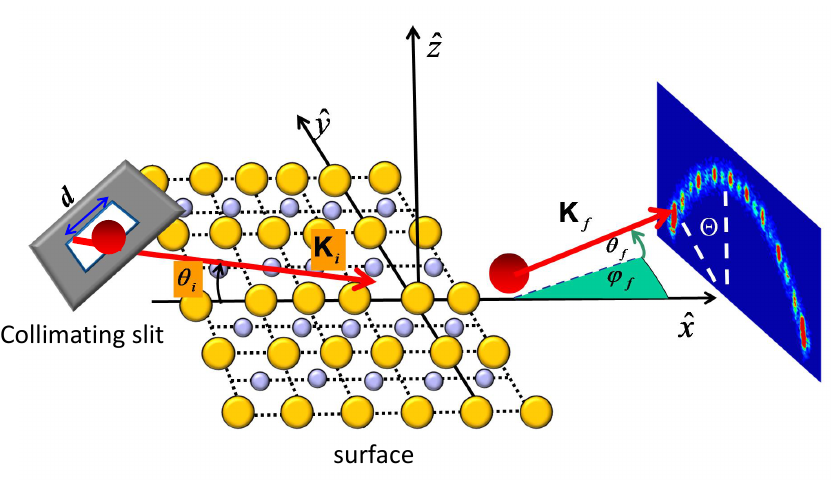
Figure 1. Sketch of the GIFAD process, together with the reference